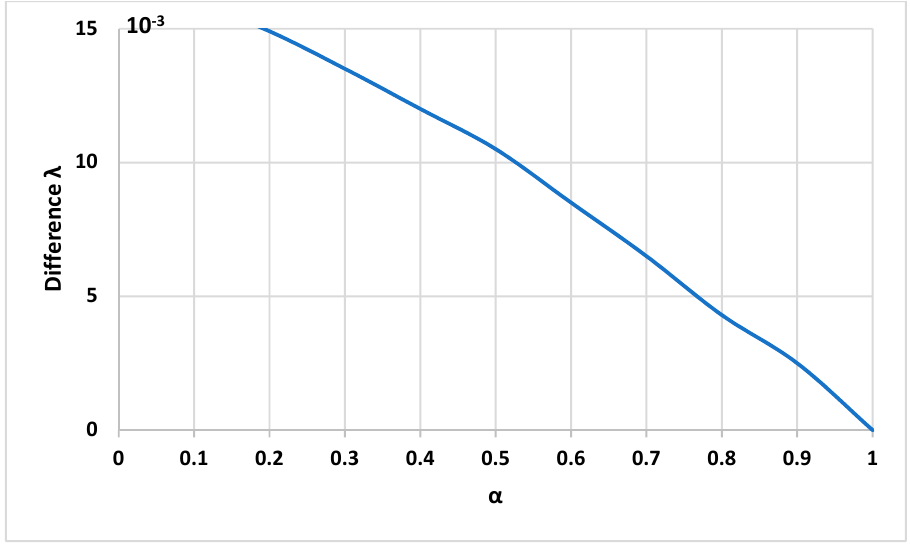
Figure 9. The difference λ between the maximum and minimum operating pressures is considered relative to α .